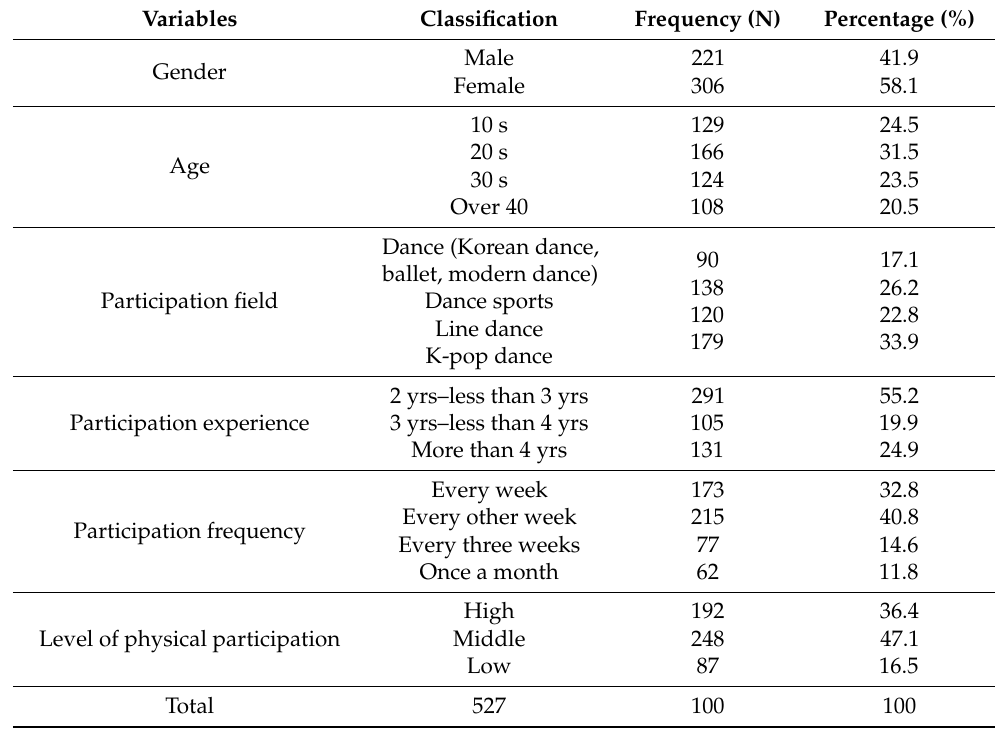
Table 1. Demographic characteristic of